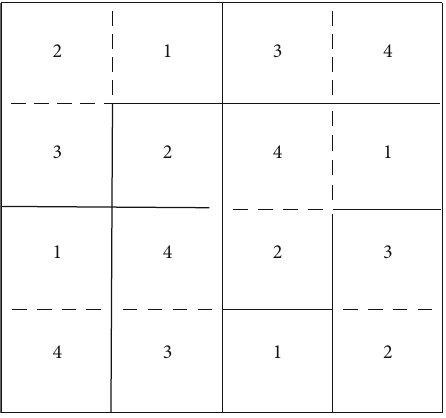
Figure 7: Basic solution of the proposed 4 × 4 KDK rebus pattern.